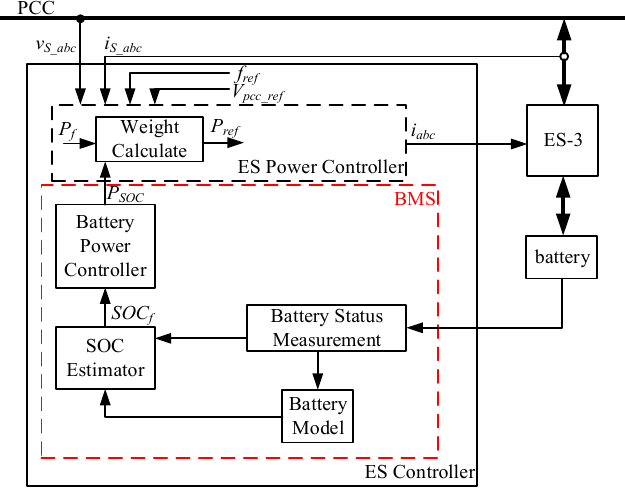
Figure 7. Power decoupling control scheme with BMS [22].